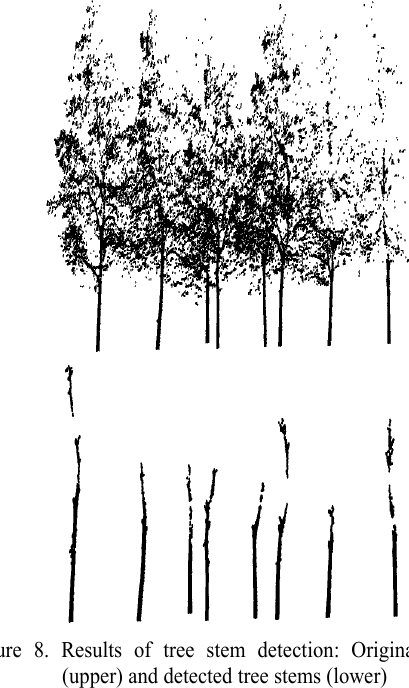
Figure 8. Results of tree stem detection: Original data set (upper) and detected tree stems (lower)